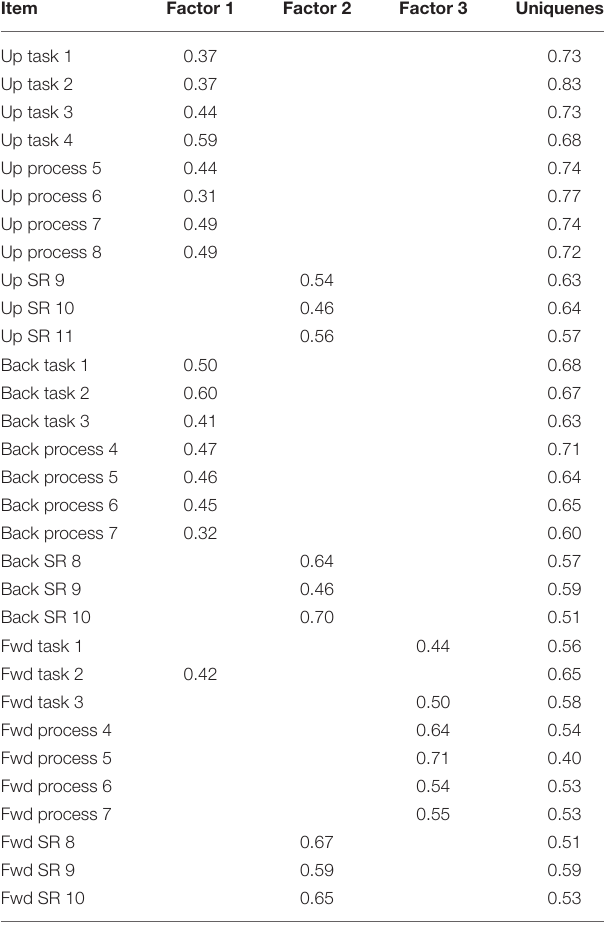
TABLE 1 | Exploratory factor analysis.